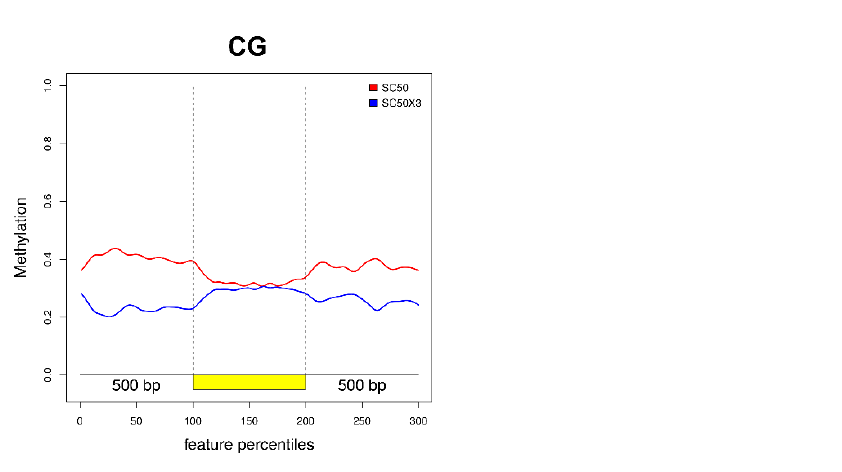
Figure 5. Plotted DMPs along the EGBs (coding region, in yellow, with the regions 500 bp upstream and downstream) for the CG context.